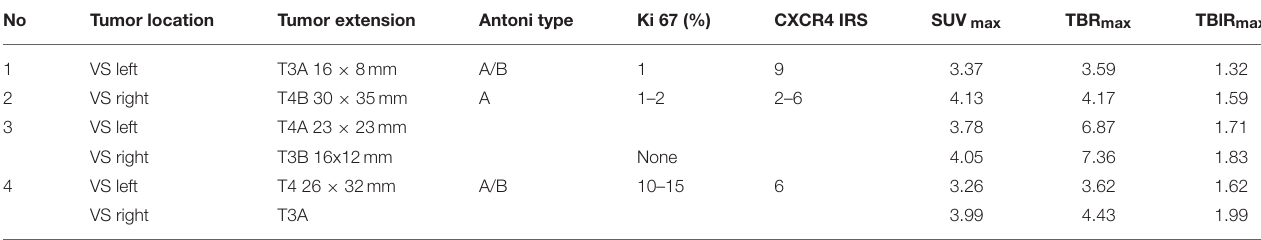
TABLE 1 | Tumor characteristics and imaging